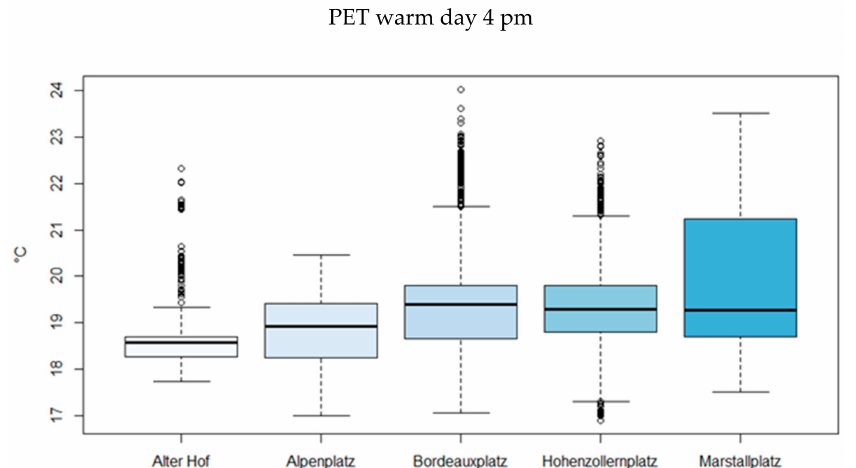
Figure 14. PET values for warm day 4